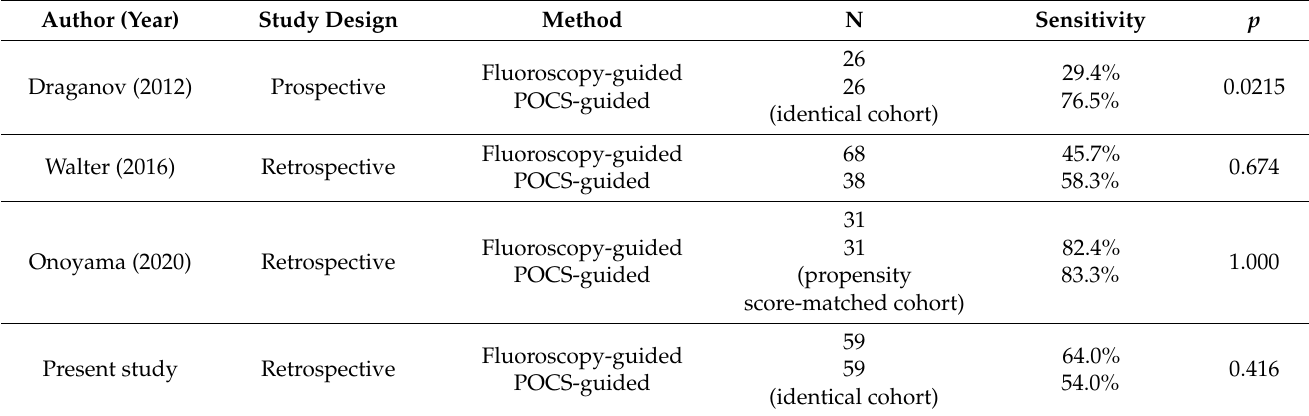
Table 5. Comparative studies of POCS-guided targeted biopsy with fluoroscopy-guided biopsy for indeterminate biliary